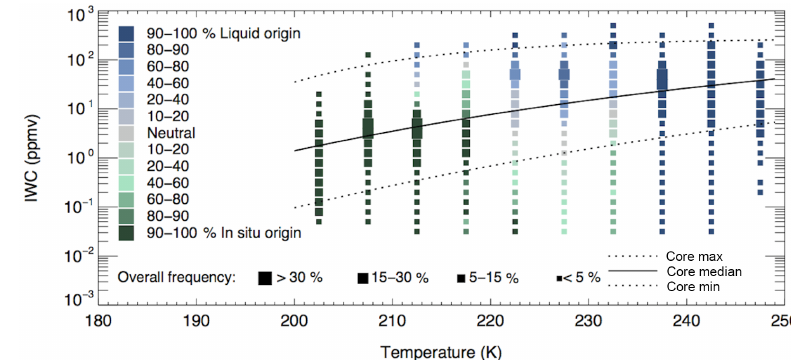
Figure 13. Probability distribution of IWC as a function of temperature for ML-CIRRUS. The size of the points represent the frequency of occurrence of each value within a 5K temperature bin, similar to the data shown in Fig. 6. The colors represent the percentage by which each point is more representative of in situ origin cirrus (greens) or liquid origin cirrus (blues). The maximum, core max, median, and core min lines (black) are from Schiller et al.